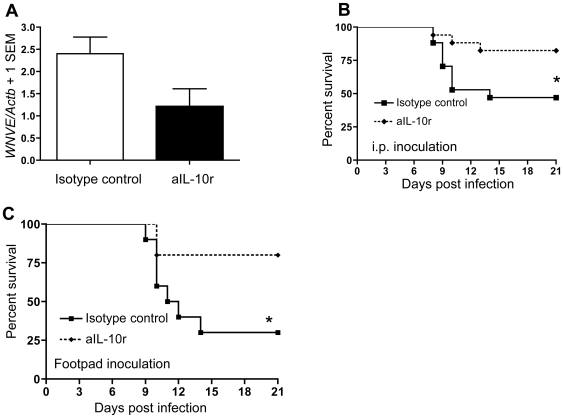
Prophylactic blockade of IL-10 signaling increases survival of WNV-infected mice.A group of C57BL6 mice were i.p. administered anti-IL-10 receptor monoclonal antibody (aIL-10r mAb) or isotype-matched IgG control antibody one day before challenge with WNV. (A), Viral load was measured in blood on day 3 p.i. by Q-PCR (p = 0.07, LD50, i.p..); (B–C), Kaplan-Meier survival analysis showed significant differences between the aIL-10r mAb and isotype-matched IgG treated group. (B, i.p. inoculation [LD50], n = 17/group, data were pooled from 3 independent experiments; C, footpad inoculation [100 pfu], n = 10/group). *p<0.05, compared to control mice.